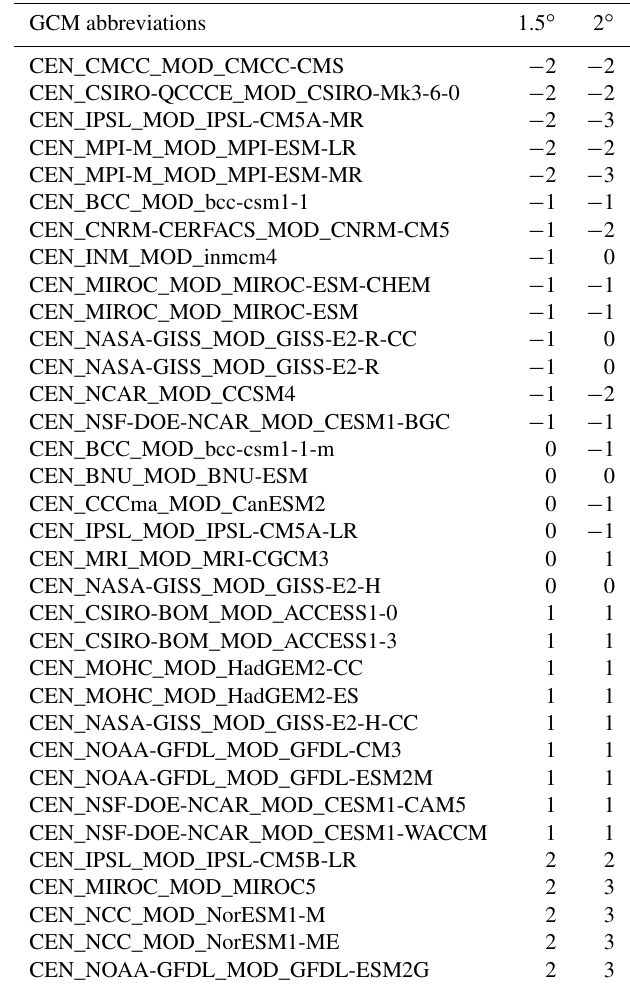
Table D1. Rounded GCM component weights relative to uniform weighting from Figs. 12 and